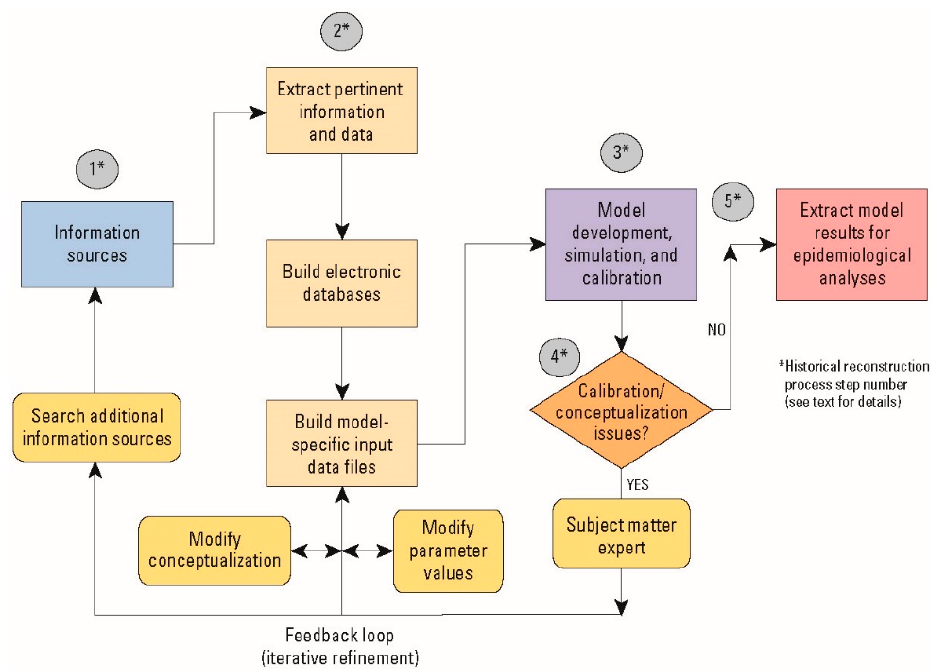
Figure 2. Generalized process of identifying information, extracting usable model ‐ specific data, and